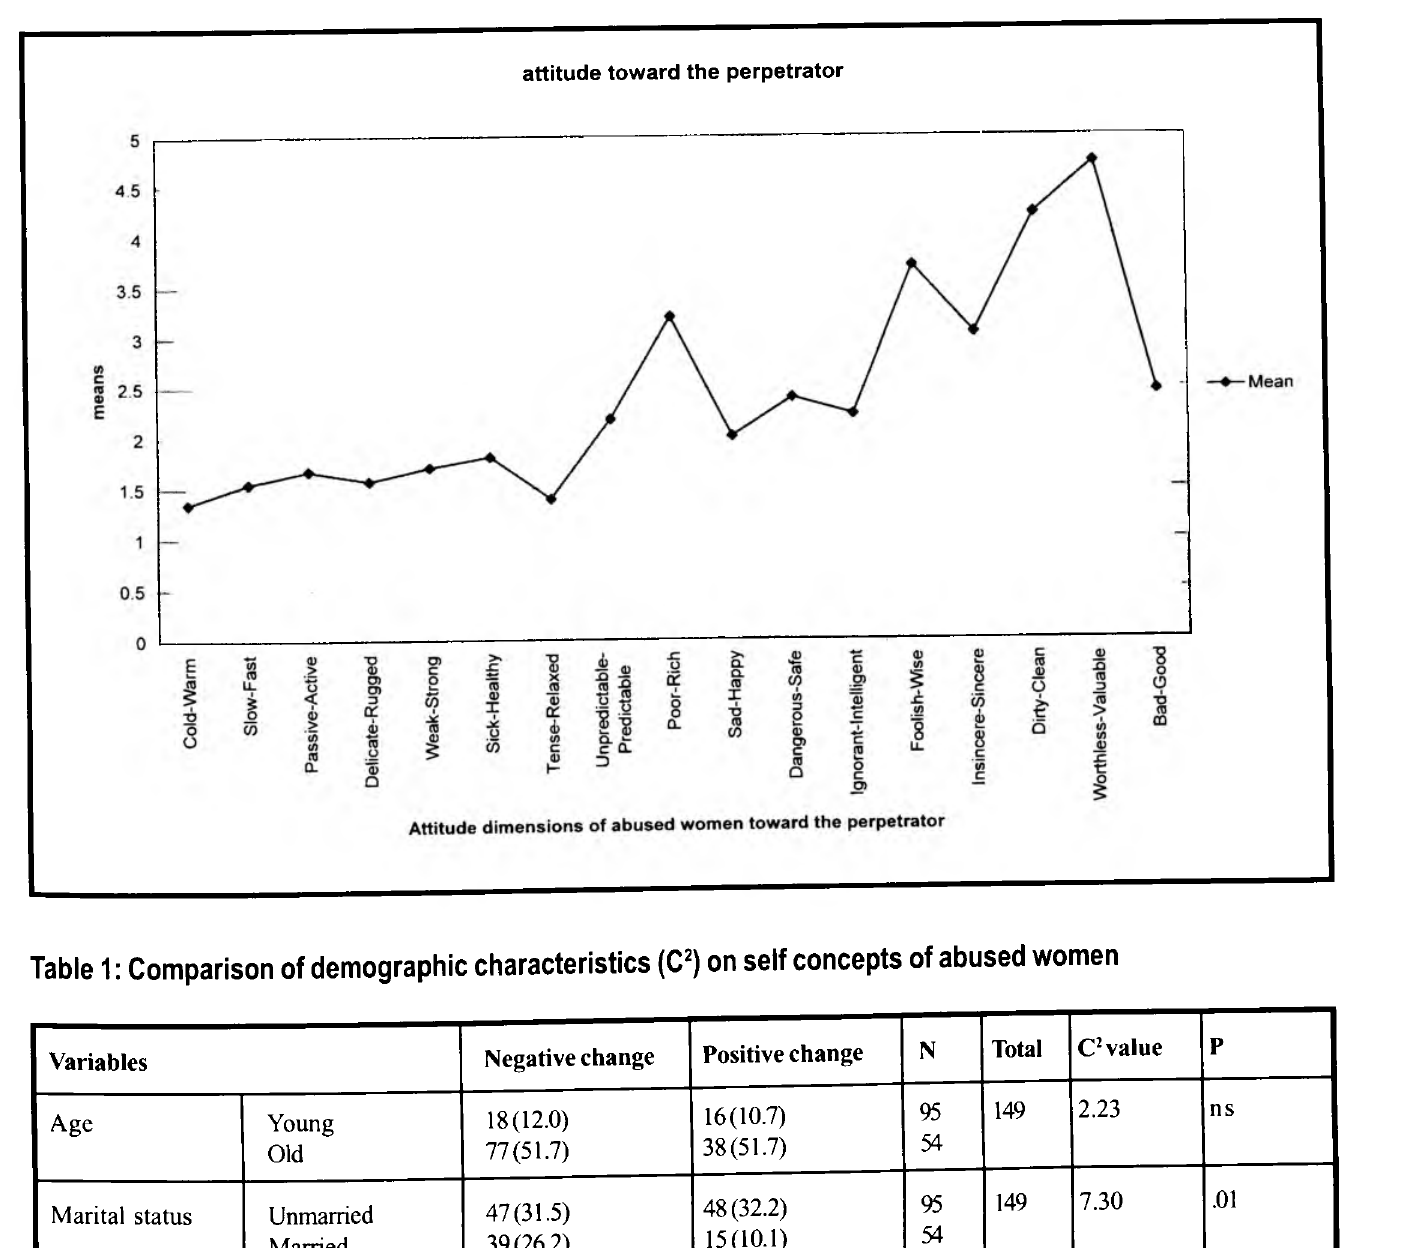
Figure 2 : Attitude toward the perpetrator